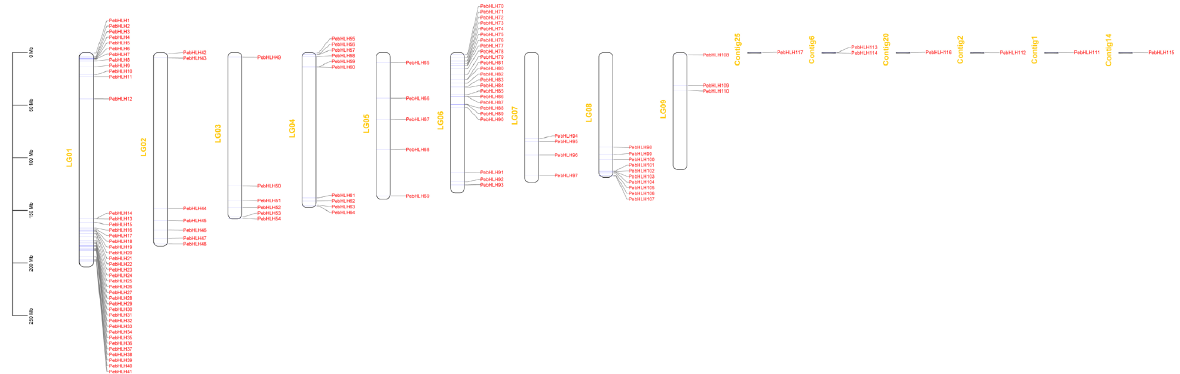
Figure 3. Locations of the 117 identified PebHLH s in 9 chromosomes of Passion fruit. The PebHLHs were located on No. 1, 2, 3, 4, 5, 6, 7, 8, and 9 chromosomes.